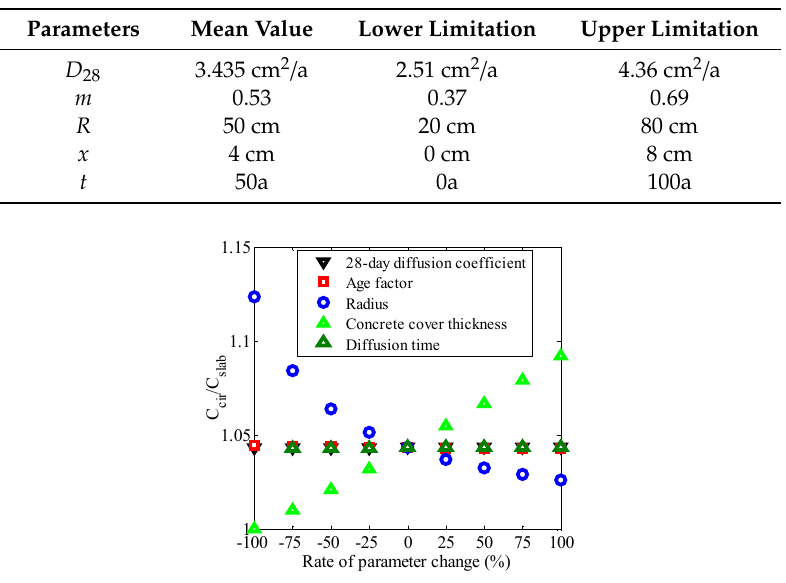
Figure 6. Sensitivity analysis of C cir / C slab with respect to the model parameters.